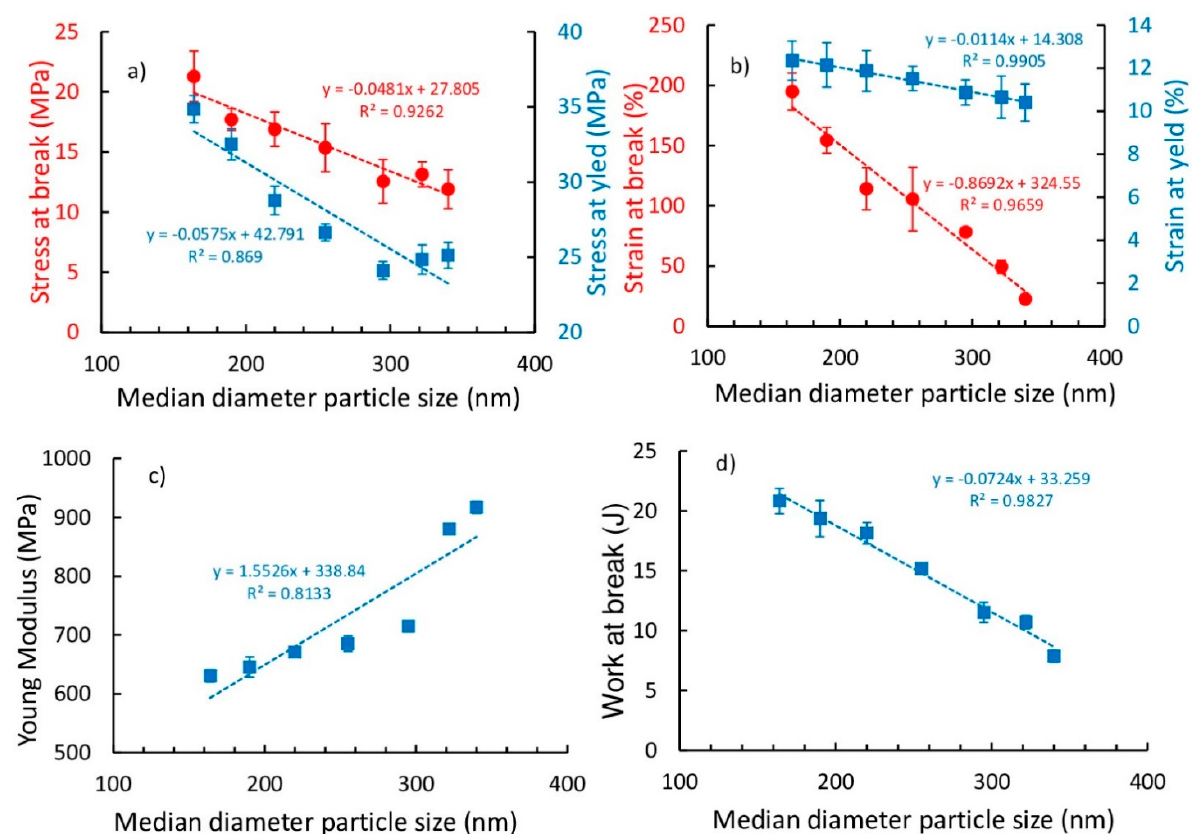
Figure 6. Tensile mechanical parameters of the pure HDPE and its composites with graphite treated at different times: ( a ) stresses at yield and break; ( b ) strains at yield and break; ( c ) Young’s modulus; and ( d ) work at break.